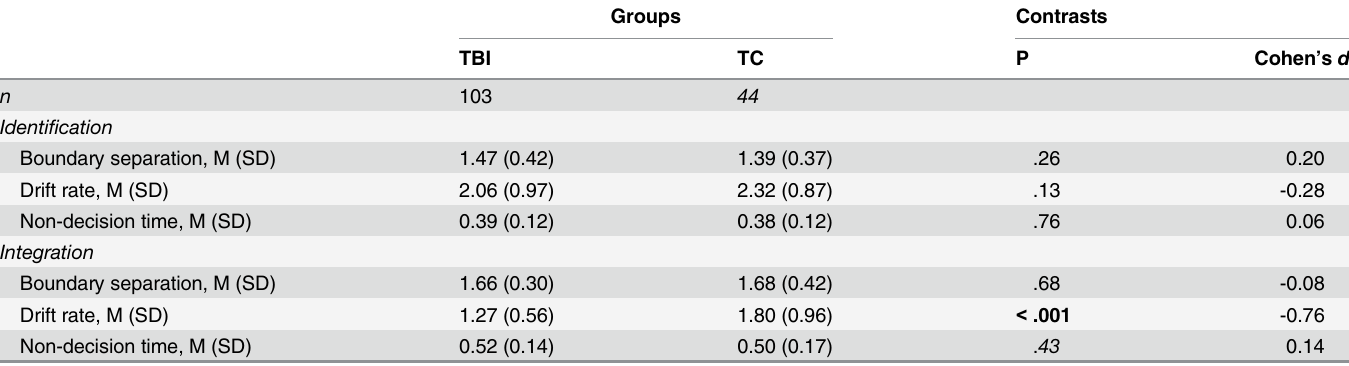
Table 3. Diffusion model analysis of visual identification and visual integration in the TBI and TC